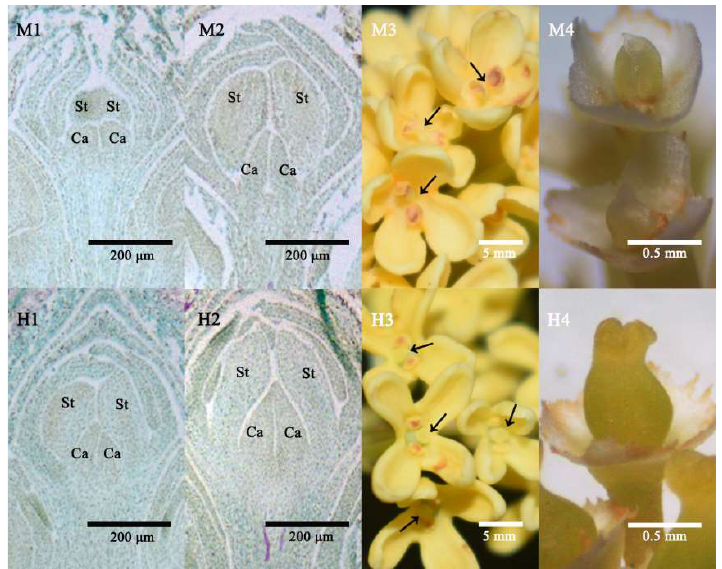
Figure 1. Three key developmental stages of male and hermaphrodite O. fragrans . ( M1 , M2 , H1 , H2 ) The first two stages were paraffin sections of flower buds. ( M3 , H3 ) A morphologic photograph of the third, full flowering stage, arrows indicate the position of the pistils. ( M4 , H4 ) Photographs of pistils of male and hermaphrodite flowers with petals and stamens removed. St, Stamen; Ca, Carpel.